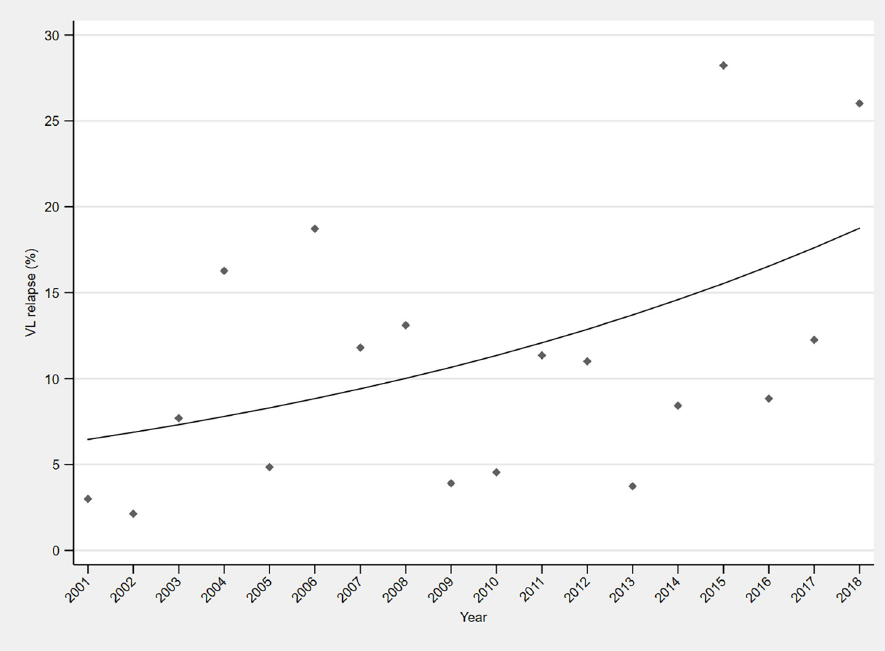
Fig 1. Trend in relapse as a proportion of visceral leishmaniasis (VL) cases treated at Me´decins Sans Fronti è res (MSF) centre in Lankien, South Sudan, 2001–2018 (from programme monitoring data) � . � Join-point analyses indicated that the best-fit (log linear) model had zero join points and an annual percent change in relapse as a proportion of all VL cases from 2001 to 2018 of 6.5% (95% CI 0.3% to 13.0%, p = 0.04).